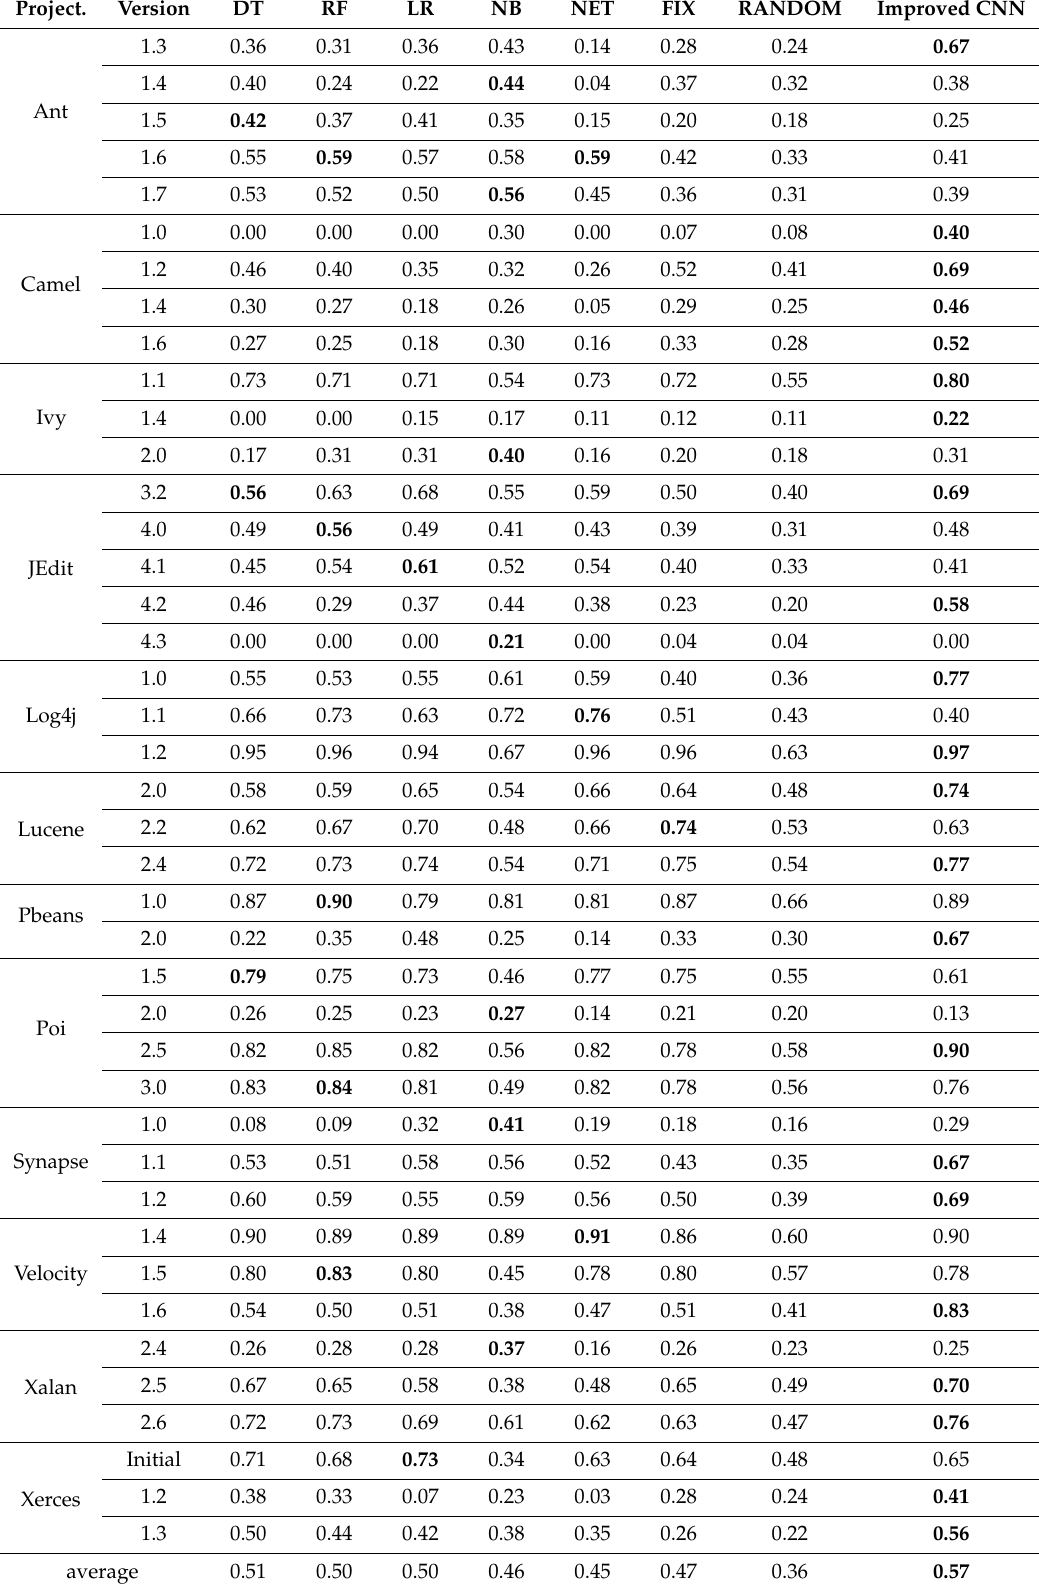
Table 6. Performance comparison of di ff erent models on the PSC dataset. The decimal values represent the average F-measure values. The best F-measures for each row are highlighted in bold. Project.